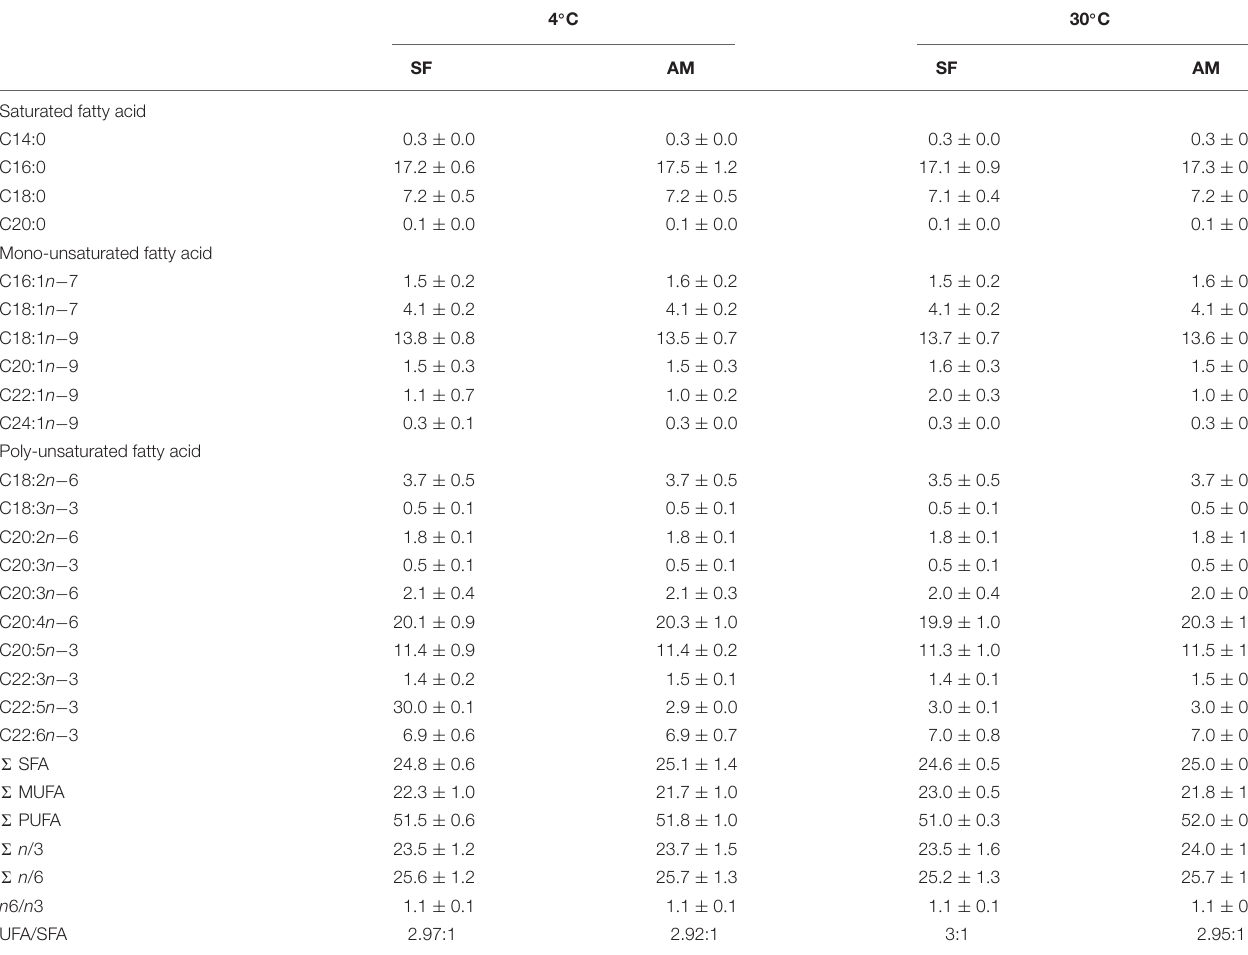
TABLE 1 | Fatty acid composition (%) of Lota lota spermatozoa diluted in seminal fluid (SF) and activation medium (AM) at different in vitro temperatures. 4 ◦